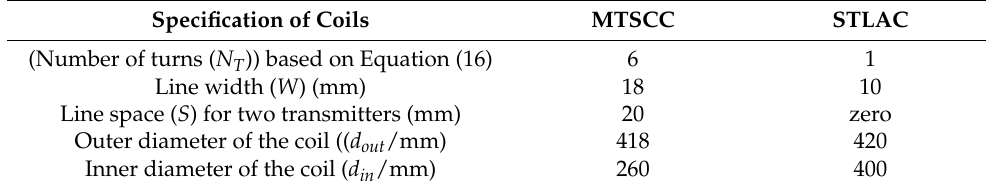
Table 3. Specifications and parameters of the transmitter and receiver coils.